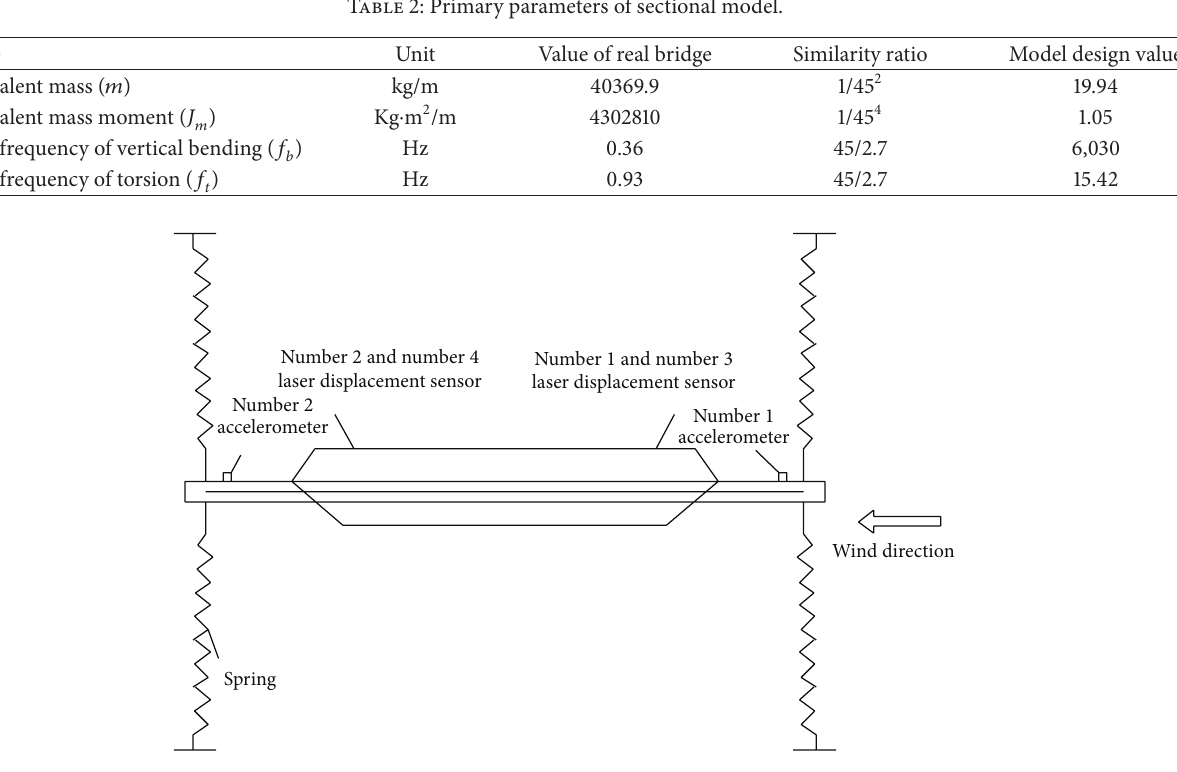
Figure 3: Layout of laser displacement sensors and laser acceleration sensors.